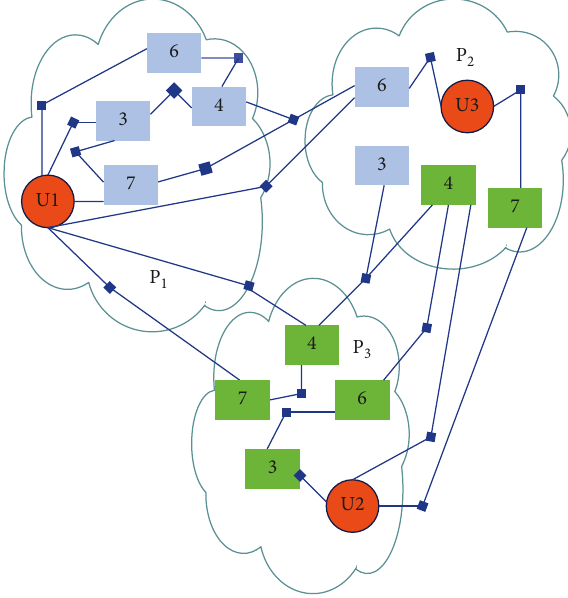
Figure 6: Results of hypergraph repartitioning ( α